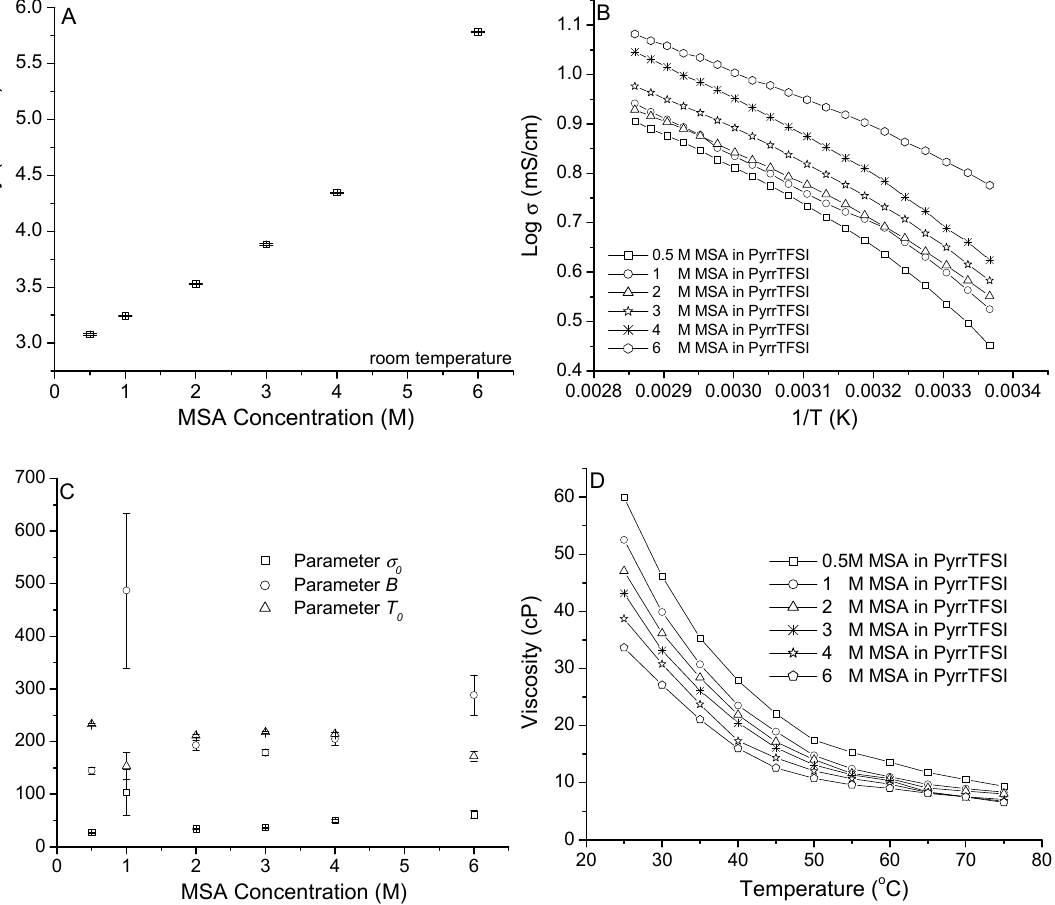
Figure 1. ( A ) Conductivity vs. MSA concentration in PyrrTFSI; ( B ) Arrhenius plots of MSA/PyrrTFSI solutions over temperature range of 23–80 °C; ( C ) Fitted values of σ 0 , B , and T 0 in the VFT equation; ( D ) Viscosity vs. temperature of the solutions with various MSA concentrations.